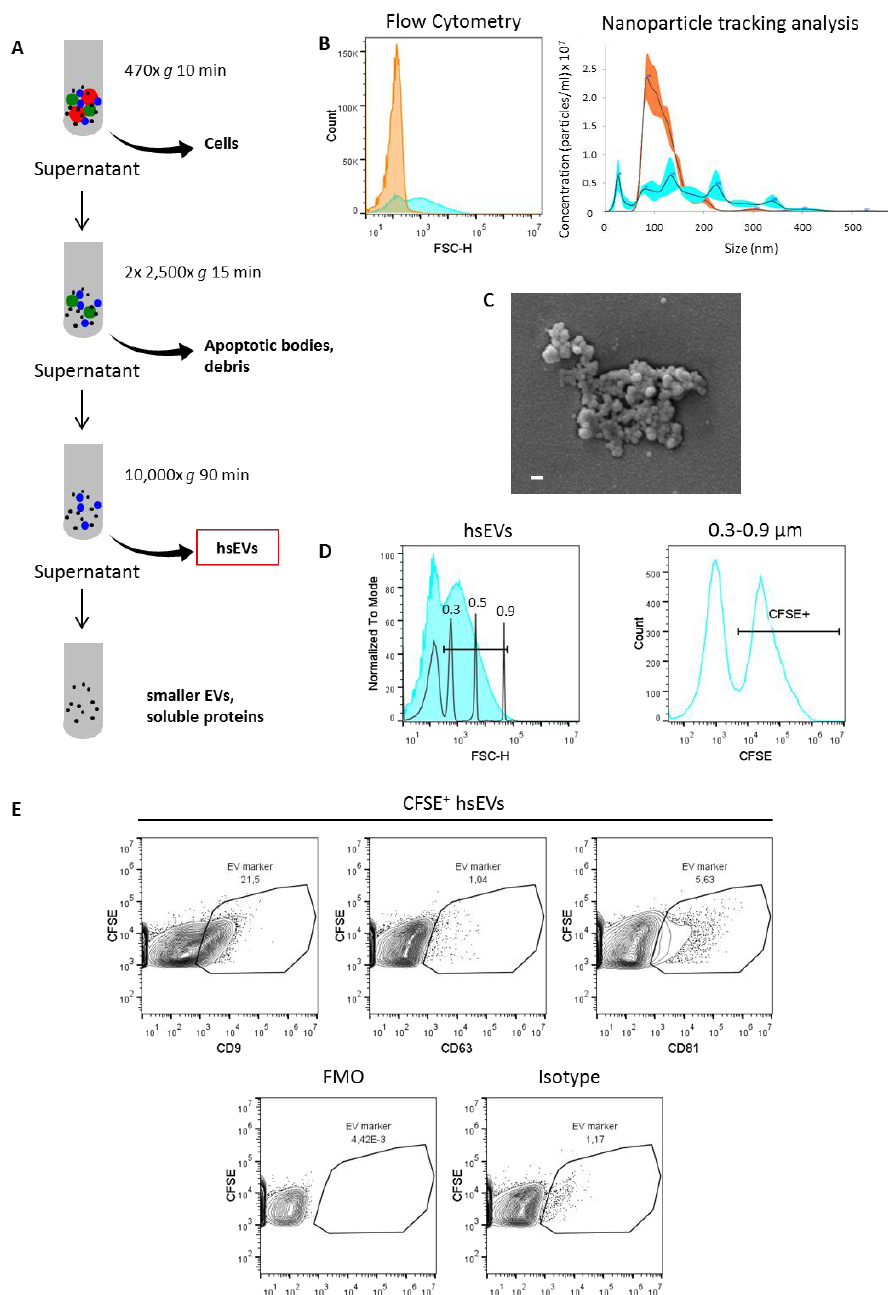
Figure 1. Identification and characterization of high-speed extracellular vesicles (EVs). ( A ) Purification of EV subsets using sequential centrifugation. ( B ) Analysis of EV size distribution by flow cytometry (left) and nanoparticle tracking analysis (NTA) (right). Orange histograms represent the supernatant, and cyan histograms represent the pellet after high-speed centrifugation. ( C ) Scanning electron microscopic image of high-speed (hs) EVs (pellet). Scale bar 100 nm. ( D ) Gating strategy for the identification of intact hsEVs by high-resolution flow cytometry. A gate representing the size range of interest (0.3–0.9 µ m) was set according to known diameters of standard beads (left). Within the estimated size range of 0.3–0.9 µ m, carboxyfluorescein diacetate succinimidyl ester (CFSE + ) events were identified as intact hsEVs (right). Samples were measured with a threshold of 0 for the FITC channel. ( E ) Flow cytometry analysis of tetraspanin markers CD9, CD63, and CD81 on hsEVs (upper panel), fluorescence minus one (FMO) control (lower panel left), and isotype control (lower panel right). Data shown are representative of three independent